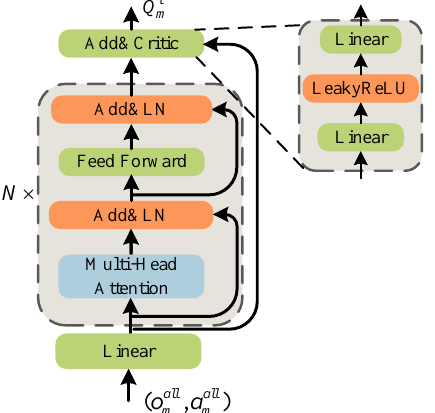
Figure 5. The structure of Hierarchical Multi-Head Attention